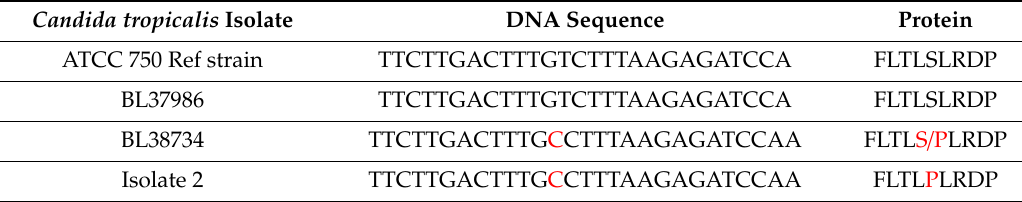
Table 4. FKS1 Hot Spot1 sequencing of the Candida tropicalis isolates.